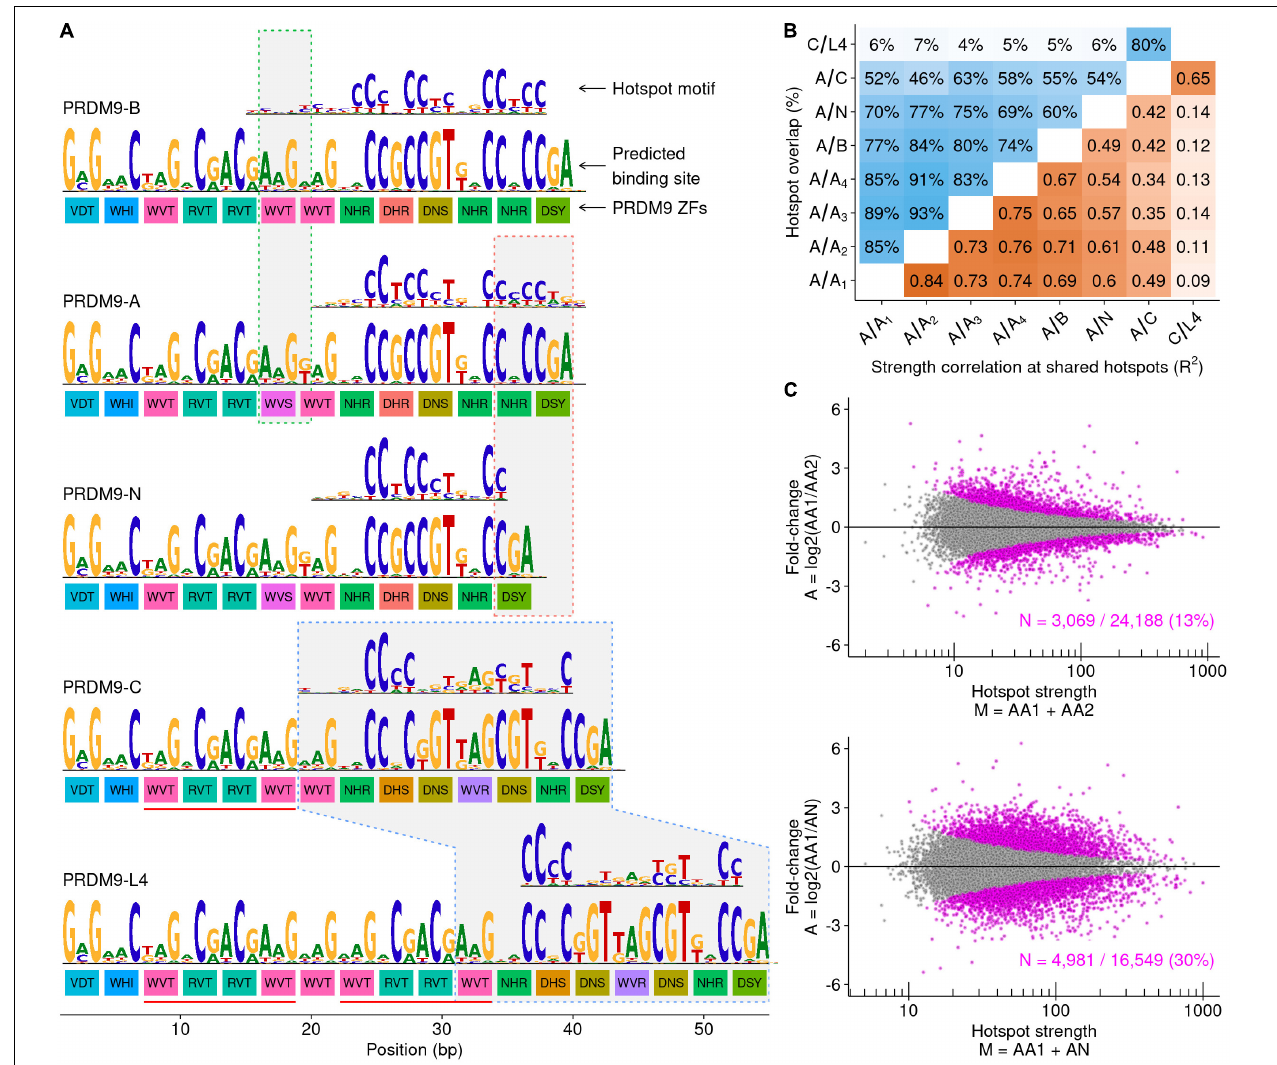
FIGURE 5 | The A -variant PRDM9-N allele substantially perturbs the DSB landscape. (A) Schematic of the PRDM9 ZF arrays and DNA binding preferences for each allele. For each allele, there are three rows of data. The colored boxes represent the amino acid sequences at the primary DNA contact residues for each C 2 H 2 ZF ( − 1, 3, and 6 positions). These amino acids confer DNA binding specificity, and ZFs with different DNA contact residues are colored differently. The binding preference for each allele is predicted from the amino acid sequence using a polynomial SVM model (Persikov and Singh, 2014). Note that despite these predictions, not all ZFs are thought to contribute to PRDM9 DNA binding. The best-scoring sequence motif identified at hotspots putatively defined by each allele is shown above each prediction. The green box highlights the region that differs between the PRDM9-A and PRDM9-B alleles. A single base pair change modifies one amino acid in the ZF array (Baudat et al., 2010). This slightly alters the predicted PRDM9 binding. The red box outlines the region that differs between the PRDM9-A and PRDM9-N alleles. The PRDM9-N allele differs by one less ZF than the PRDM9-A allele. The blue box outlines the region that binds DNA in both the PRDM9-C and PRDM9-L4 alleles. The four PRDM9-C ZFs underlined in red are duplicated in the PRDM9-L4 allele. (B) Hotspots were identified in all samples, and overlapping hotspots were counted. The maximum reciprocal overlap is shown (top left; blue shading). At shared autosomal hotspots, the correlation between hotspot strength was calculated (bottom right; orange shading; R 2 = squared Pearson correlation coefficient of log-transformed strength values). (C) MA plots depicting significantly different shared hotspot usage between (top) two A/A individuals and (bottom) the A/A 1 and A/N individuals. Each point represents one shared hotspot. Hotspots with differing strength are highlighted in magenta (Bonferroni-corrected binomial P -value <